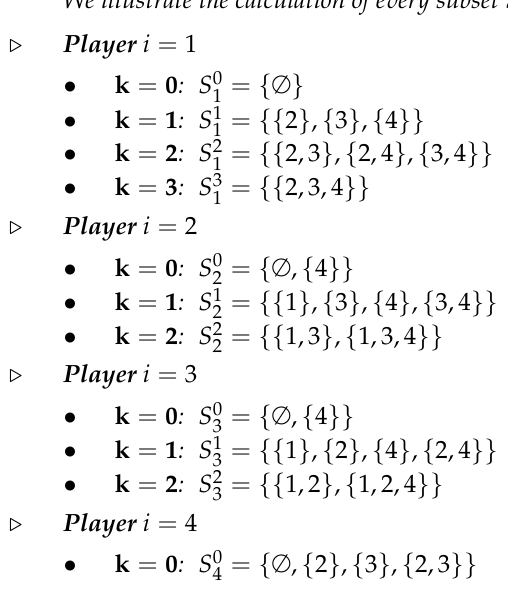
calculation. i with degree k for each single player i